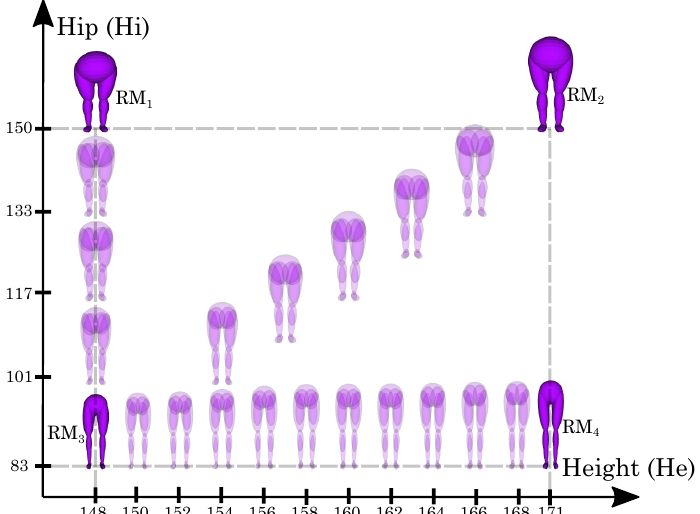
Figure 17. Example of synthesized lower body neighborhoods using segmented interpolation scheme. Synthesized mannequins are transparent. Reference Mannequins (RM) are marked with RM i . RM 1 : Small Chubby. RM 2 : Tall Chubby. RM 3 : Small Slim. RM 4 : Tall Slim.